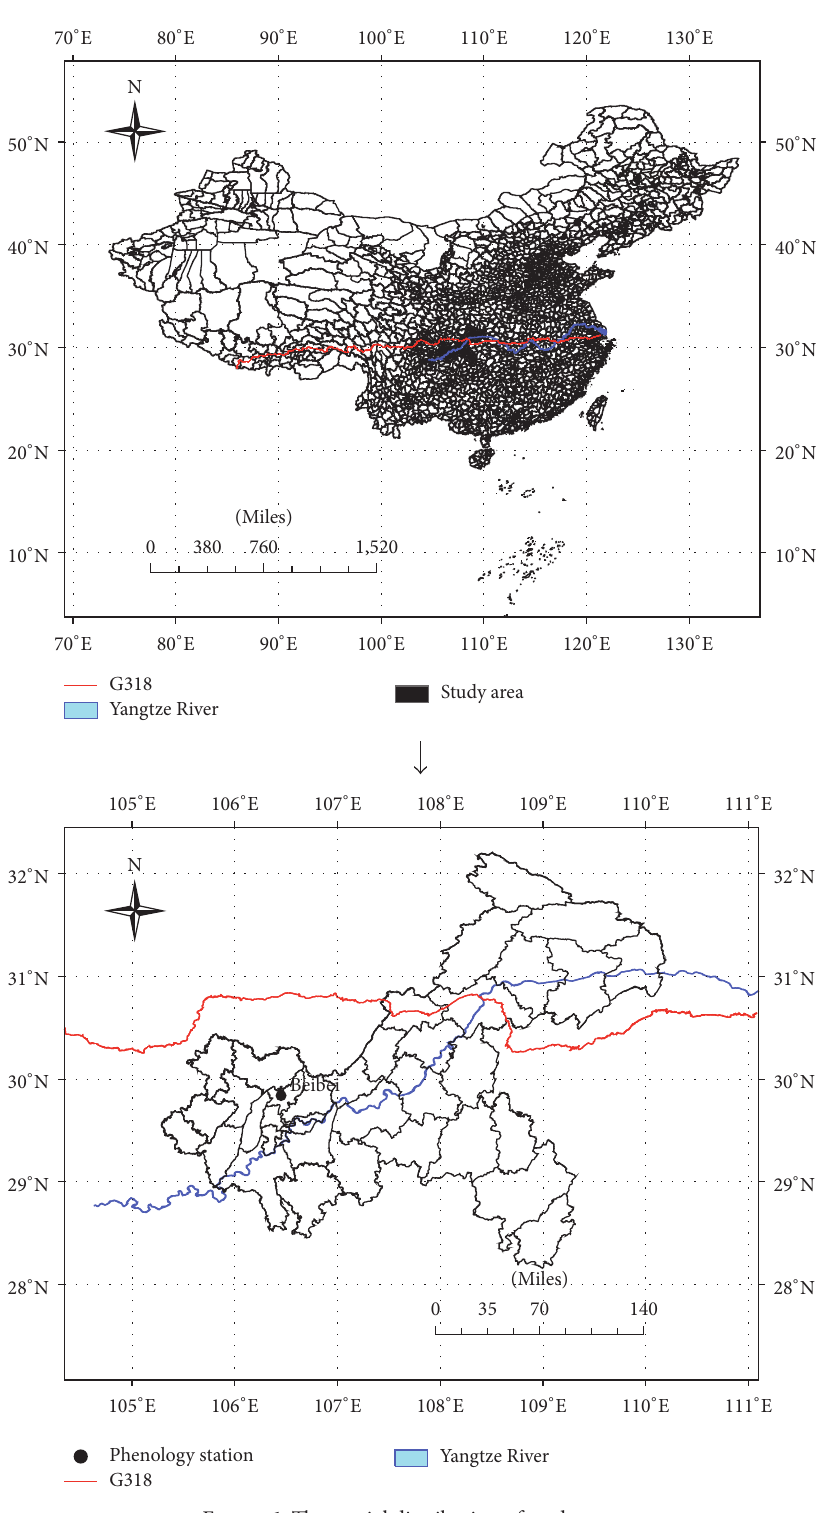
Figure 1: The spatial distribution of study